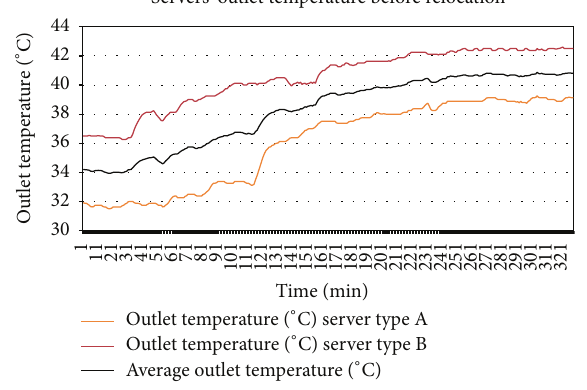
Figure 8: The outlet temperatures from SLI tests of servers before relocation.